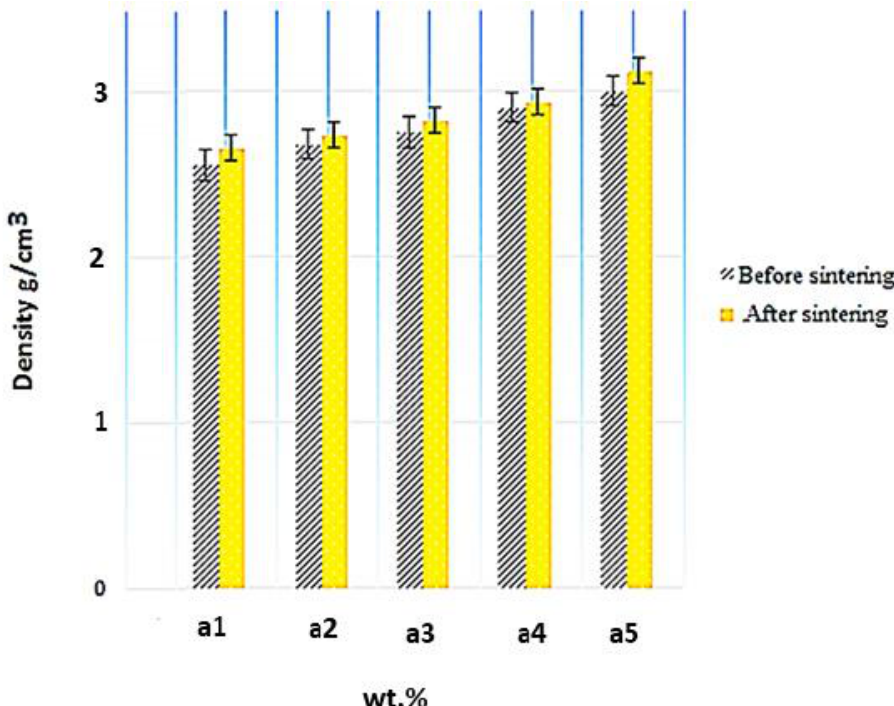
Figure 9. Evolution of density after and before sintering depending on the filler. The density measurement for Al-Fe 3 O 4 was performed using Archimedes’